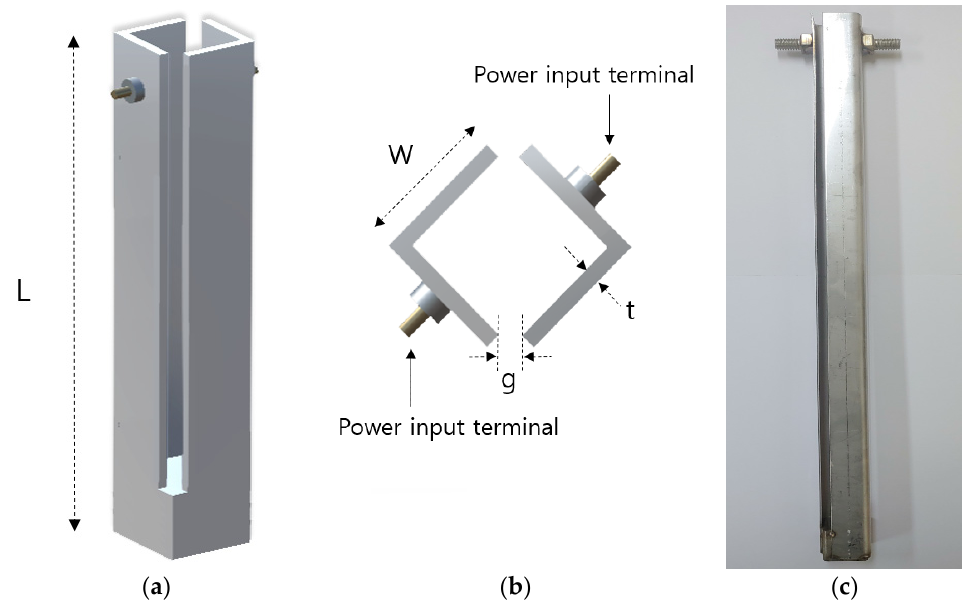
Figure 3. Structure of the heater rod: ( a ) side view (L= 500 mm); ( b ) top view (W = 2 mm, t = 0.1 mm, g = 0.3 mm); ( c ) photo of the heater.